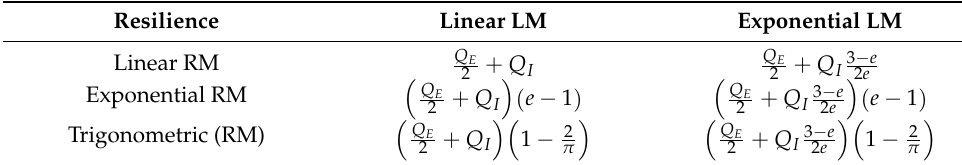
Table 1. Resilience calculation for linear, exponential, and trigonometric Recovery Model and linear and exponential Loss Model.